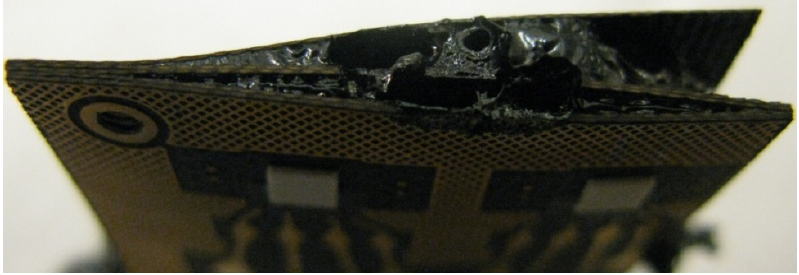
Figure 9. Inner layer after testing.